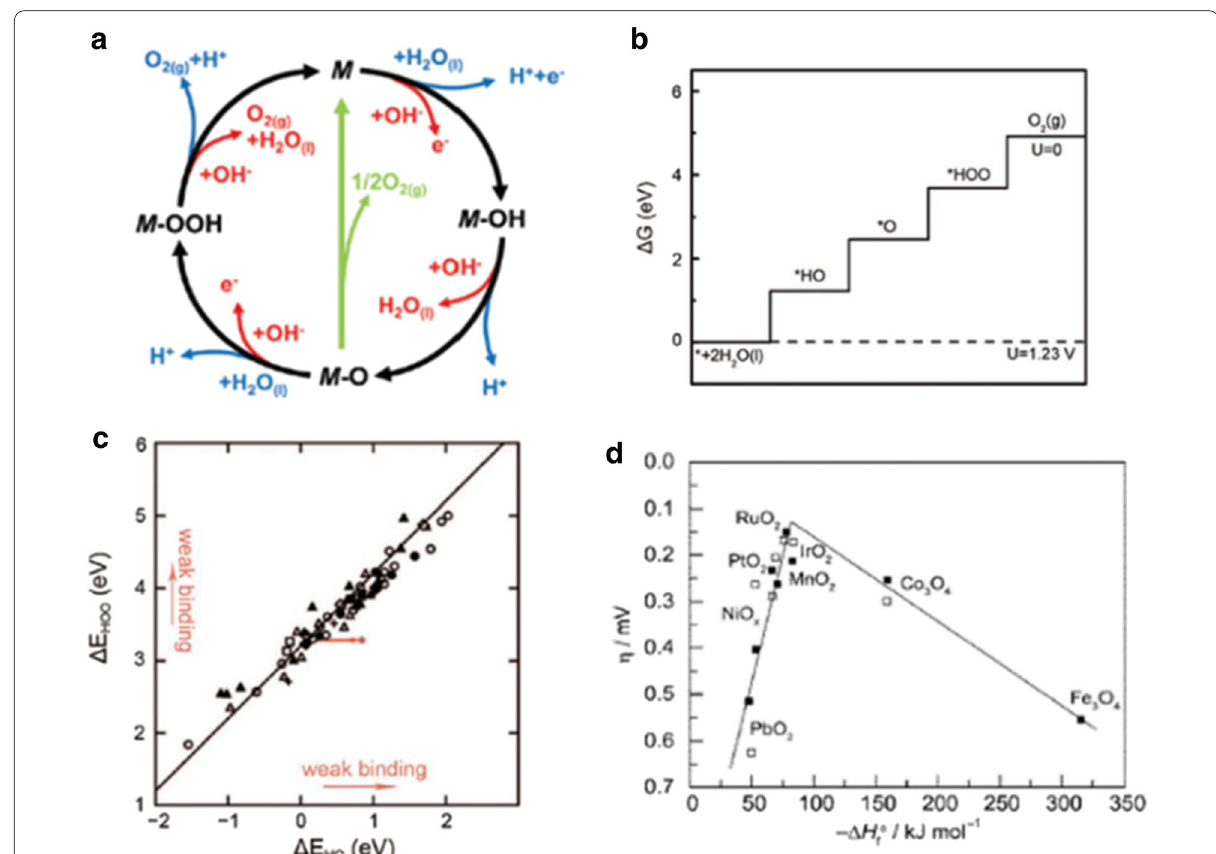
Fig. 9 a OER mechanisms in acidic (blue line) and alkaline (red line) electrolytes (Figure reprinted with permission from Ref. [5]). b Free energy diagram at U 0 and U 1.23 V for OER on the ideal catalyst (Figure reprinted with permission from Ref. [55]). c Relationship between the = = adsorption energies of *OOH and *OH on a series of oxide OER catalysts (Figure reprinted with permission from Ref. [56]). d Volcano‑shaped relationship between OER activities on metal oxide surfaces vs. enthalpy for the transition metal oxides in acidic (black square) and basic solution (white square) (Figure reprinted with permission from Ref.